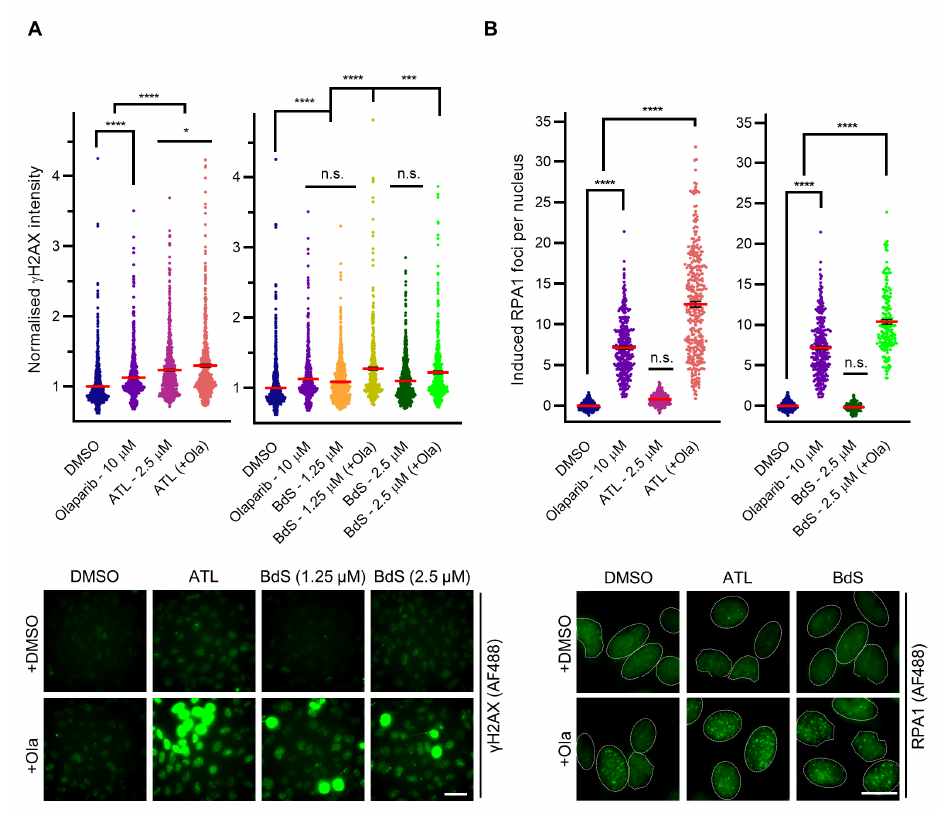
Figure 3. BdS and alantolactone (ATL) potentiate olaparib-mediated DNA damage and replication stress-related RPA consumption. ( A ) Quantification (top) and representative images (bottom) of normalised nuclear γ H2AX immunofluorescence intensity (Alexa Fluor 488; AF488) of ≥ 20,000 U2OS cells ( ≥ 3 independent experiments; n ≥ 504) following 24 h treatment with olaparib, BdS and/or ATL as indicated, compared to vehicle only (DMSO). Data points correspond to each recorded field (mean ± SEM). DMSO and olaparib control datasets are identical due to forming part of the same experimental pipeline. Scale bar—50 µ m. ( B ) Quantification (top) and representative images (bottom) of induced RPA1 foci per cell (Alexa Fluor 488; AF488) of ≥ 9000 U2OS cells ( ≥ 3 replicates; n ≥ 168) after 24 h treatment with olaparib, BdS, and/or ATL as indicated, compared to vehicle only (DMSO). Data points relate to each recorded field (mean ± SEM). DMSO and olaparib control datasets are identical due to forming part of the same experimental pipeline. Nuclei are outlined in white using DAPI as a reference. Scale bar—20 μ m. Statistical significance indicated as follows: n.s.— p > 0.05, *— p < 0.05, ***— p < 0.001, and ****— p < 0.0001.